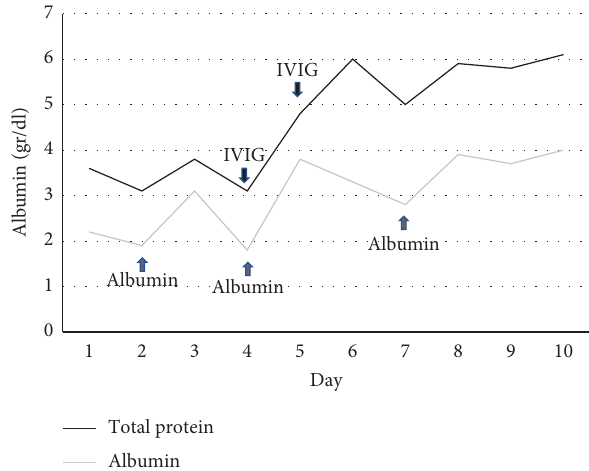
Figure 1: Total protein and albumin levels. : IVIG treatment 1gr/ kg. : Human albumin